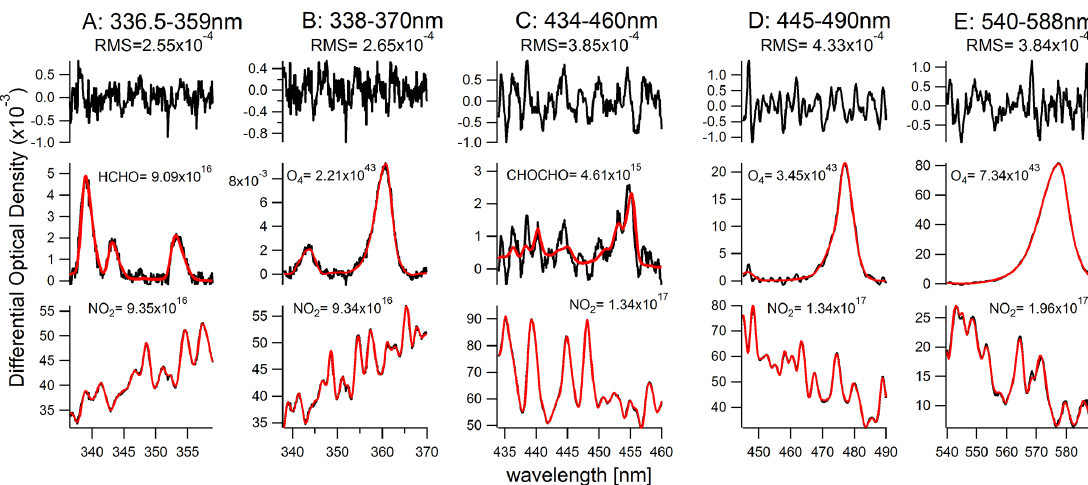
Figure 3. Spectral proofs for the detection of (a) HCHO, (b) O 4 at 360nm, (c) CHOCHO, (d) O 4 at 477nm, (e) O 4 at 577nm, and NO 2 (all panels) on 17 June 2013 at 14:23UTC, with SZA = 43.2 ◦ , EA = 2 ◦ , and AA = 50.8 ◦ from the roof of Max Planck Institute in Mainz, Germany. Black lines represent measured spectra; red lines are scaled reference cross sections in dSCD units for CHOCHO, HCHO, NO 2 (moleculescm − 2 ) , and O 4 (molecules 2 cm − 5 ) .